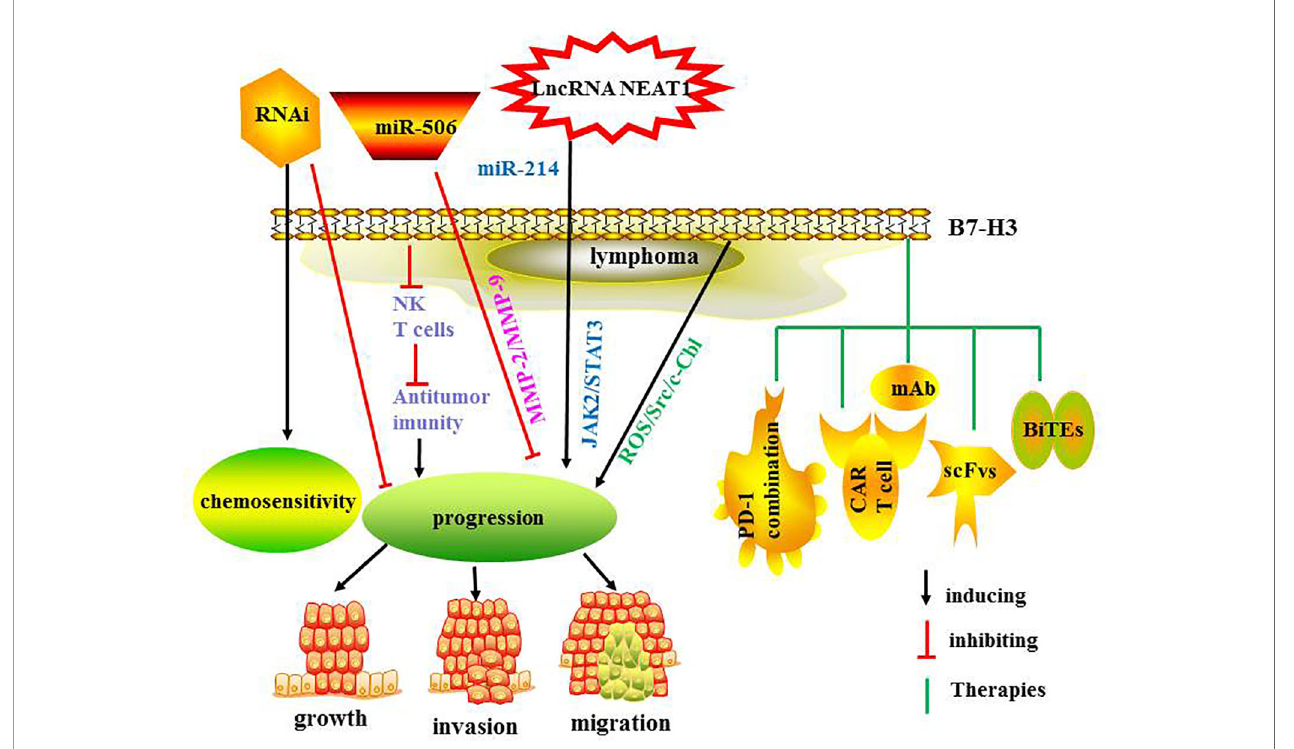
FIGURE 3 | The regulatory mechanisms and therapies targeting